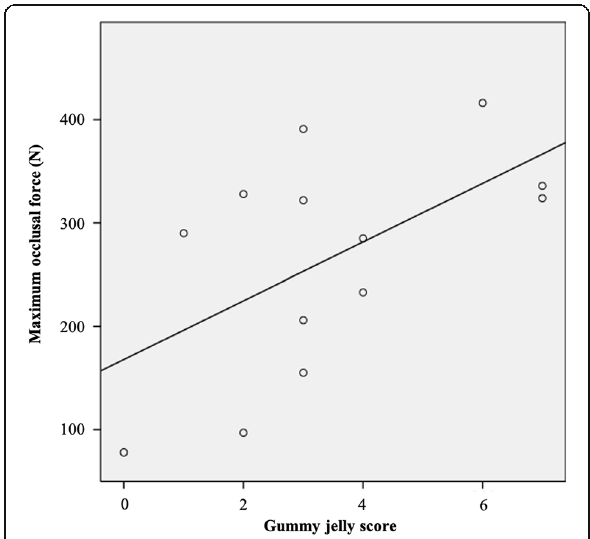
Fig. 3 The scatter diagram shows the relationship between maximum occlusal force and gummy jelly. Significant positive correlation was observed ( r = 0.537, P = 0.025) in a 5-year follow-up period. Solid line represents regression